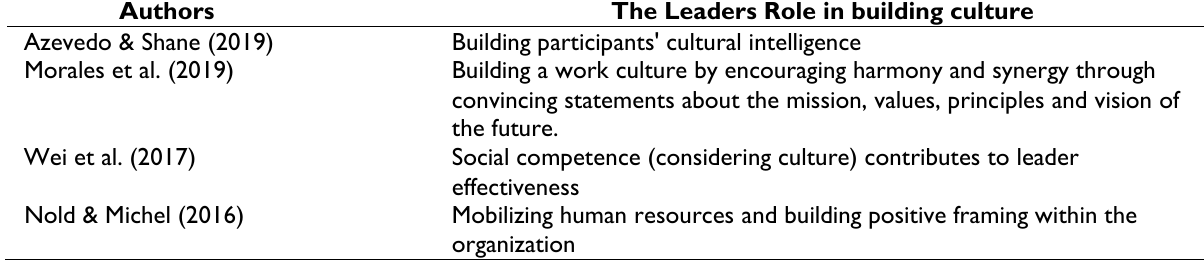
Table 8: Building Organizational